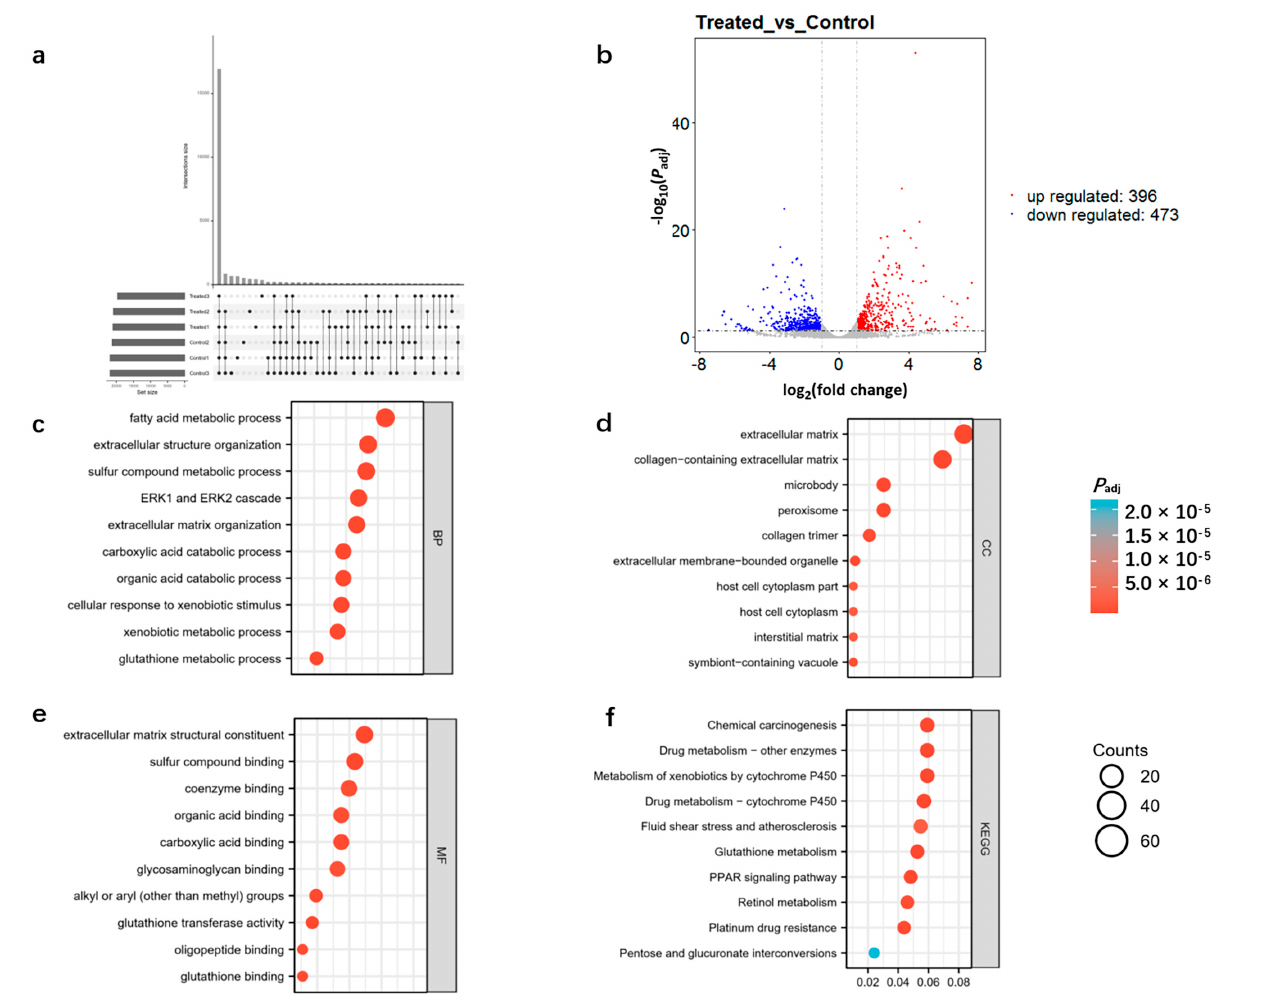
Figure 2. Transcriptome profiles of control and DQ-treated kidney tissues. ( a ) Summary of transcriptome datasets: 16,927 genes were expressed in all samples, N = 3. ( b ) The volcano plot of differentially expressed genes (DEGs) between the control and DQ-treated groups. ( c ) The enriched biological processes of DEGs. ( d ) The enriched cellular components of DEGs. ( e ) The enriched molecular function of DEGs. ( f ) The top 10 enriched Kyoto Encyclopedia of Genes pathways of DEGs and their contraction.